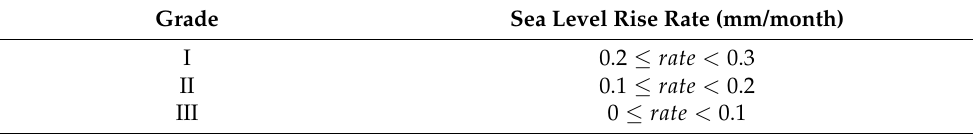
Table 4. Grade of sea level